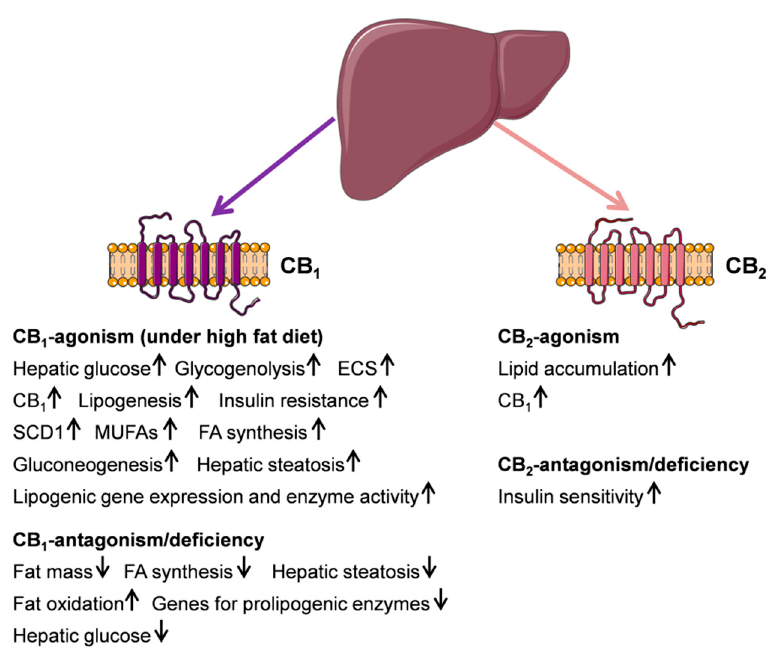
Figure 1. Schematic illustration of cannabinoid receptor (CBR) function in liver metabolism. ( ↑ ) and ( ↓ ) define up or down regulation. Most findings were generated in rodent models. This figure was prepared using a template on the Servier Medical Art website (Available at: http://smart.servier.com/).